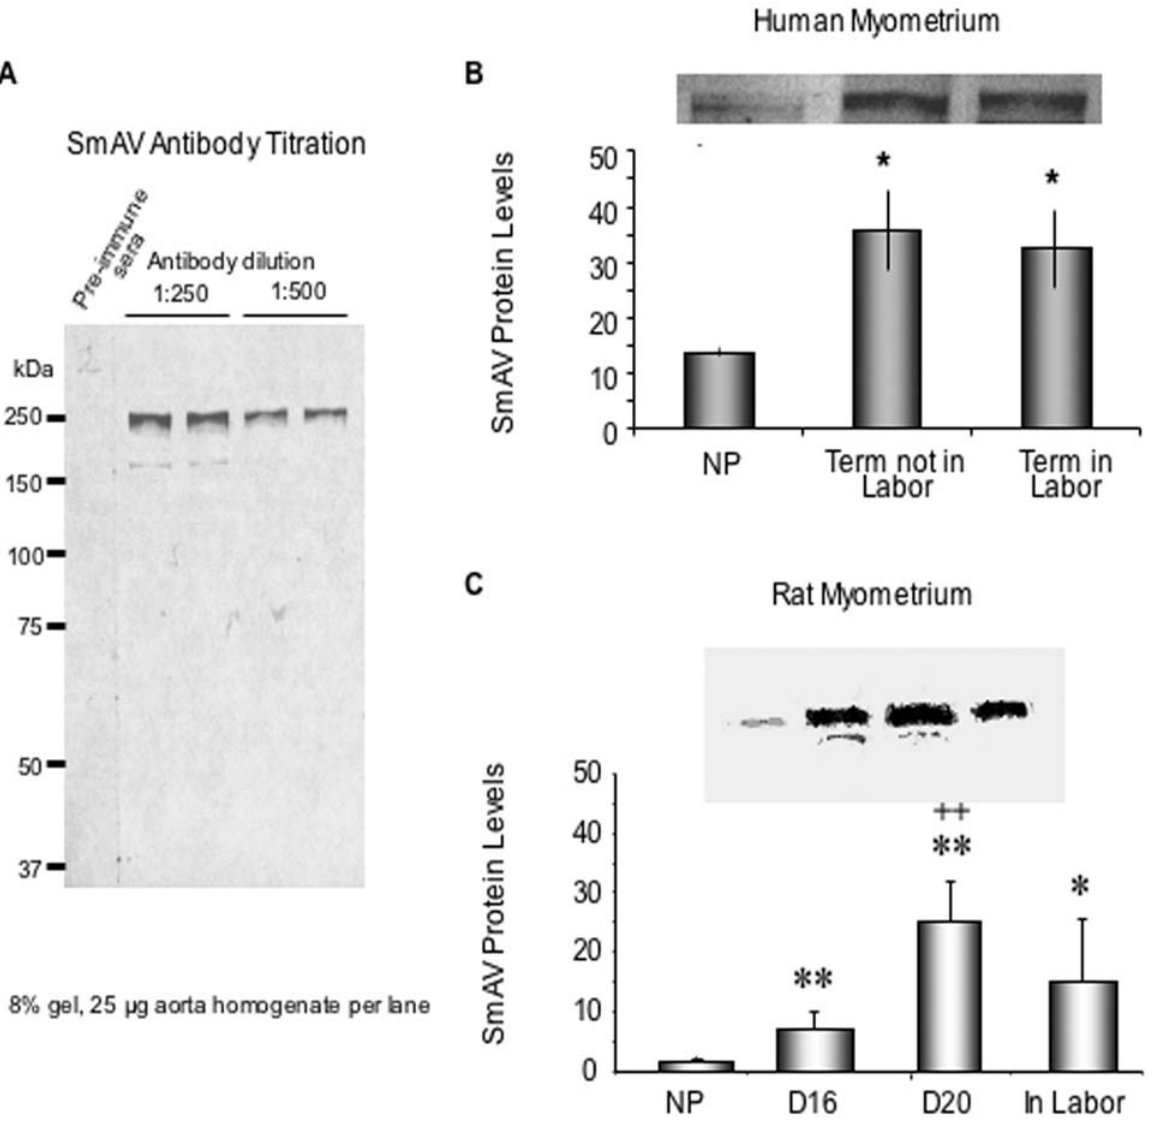
Figure 7. SmAV protein content increases with gestation in both the human and the rat. A. Specificity of the anti SmAV antibody. B. Gestation-dependent increase in SmAV expression in human myometrium. Densitometry analysis of smooth muscle Archvillin (SmAV) protein levels from immunoblots of human myometrium from nonpregnant (NP) and pregnant women. A typical blot is shown on the top. *p , 0.05 vs. NP. n=5–7 samples in each group. C. Gestation-dependent increase in SmAV expression in rat myometrium. A typical blot is shown on the top. *p , 0.05 compared to NP, **p , 0.01 compared to NP. ++ p , 0.01 compared to D16. n=4 in each group. NP, nonpregnant, D16 and D20, pregnant day 16 or day 20.